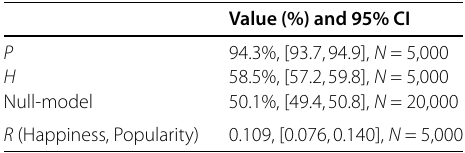
Table 1 Magnitude of Friendship Paradox, Happiness Paradox (compared to null-model produced by randomly re-assigning SBW values across all subjects), and Happiness-Popularity correlation coefficient (Pearson’s R ) for all subjects ( N =